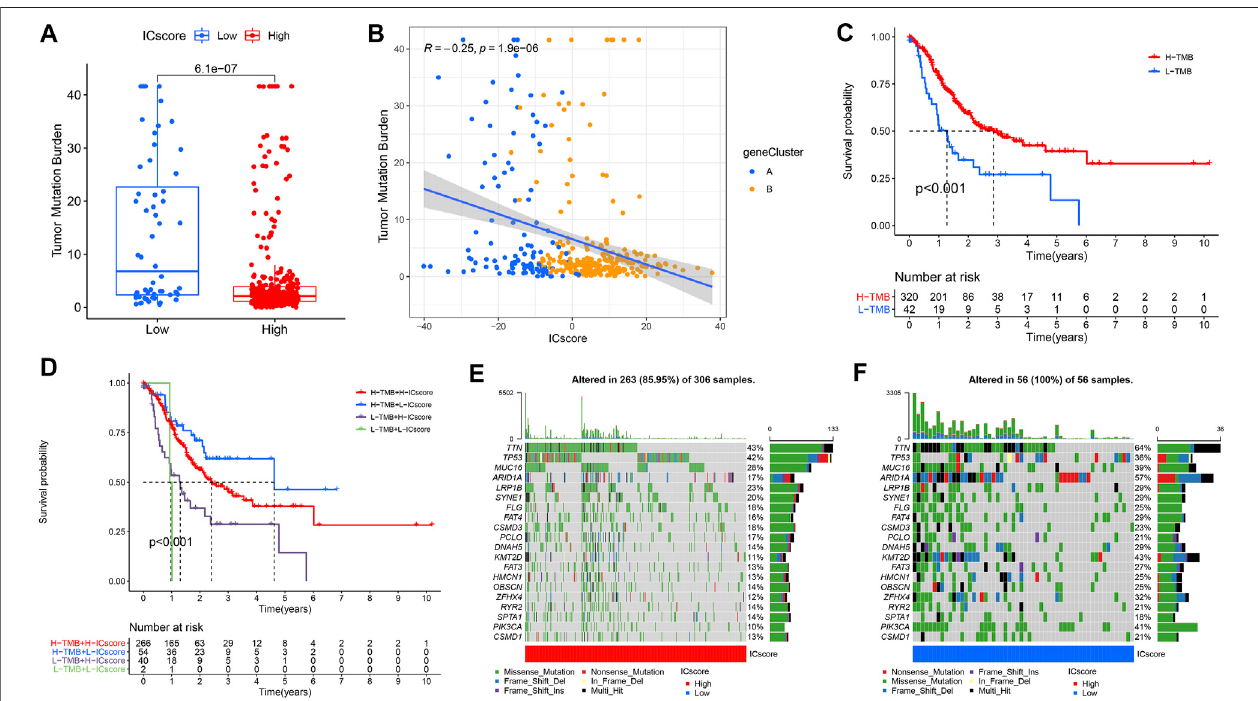
FIGURE5| CharacteristicsofICscore signaturesinTMB. (A) Differences inTMBbetweenhighand lowICscore groups. (B) The relationshipbetweenICscore and TMB. (C) Survival analyses for low and high TMB patient groups in TCGA-STAD cohort. (D) Survival analyses for patients with different degrees of TMB and ICscore. (E,F) The waterfall plot of TMB established by those with high ICscore and low ICscore.